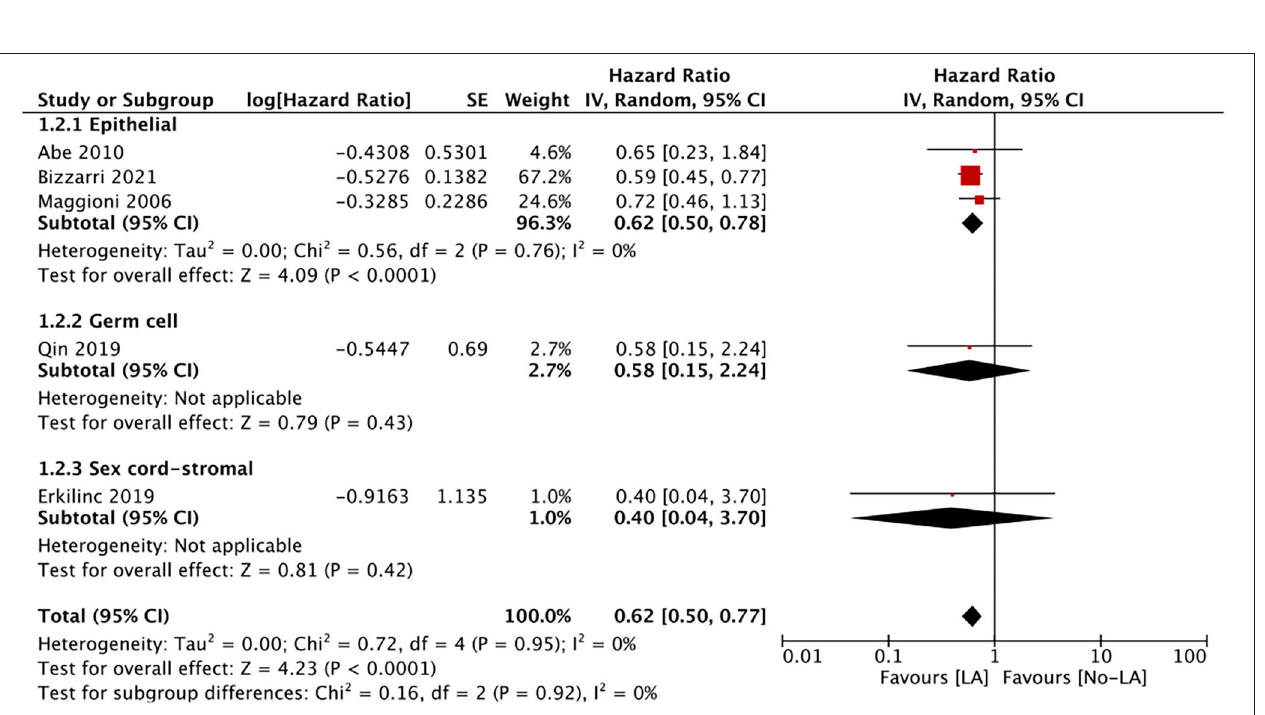
was still associated with better DFS but not in OS as compared to no lymphadenectomy. Thus, given the significant heterogeneity in the studies for adjuvant therapy, strong conclusions cannot be derived and there is a need for large- scale RCTs to confirm the benefits of lymphadenectomy for epithelial